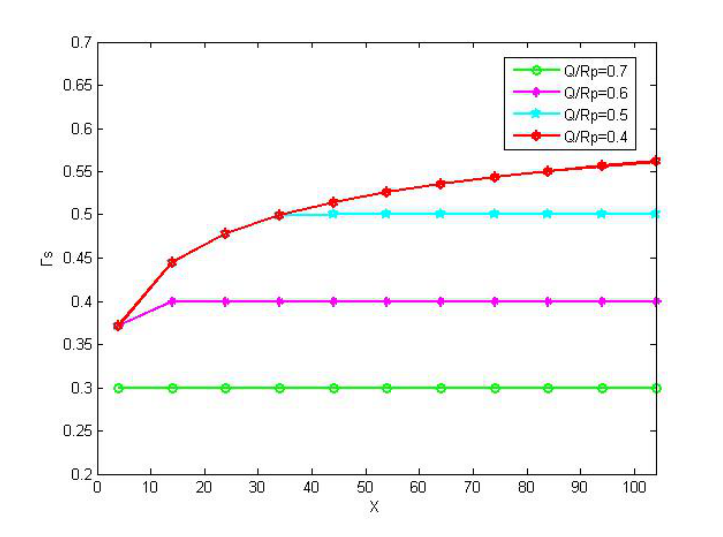
Figure 6. Optimal save-ratio in leasing and energy harvesting mode with different Q